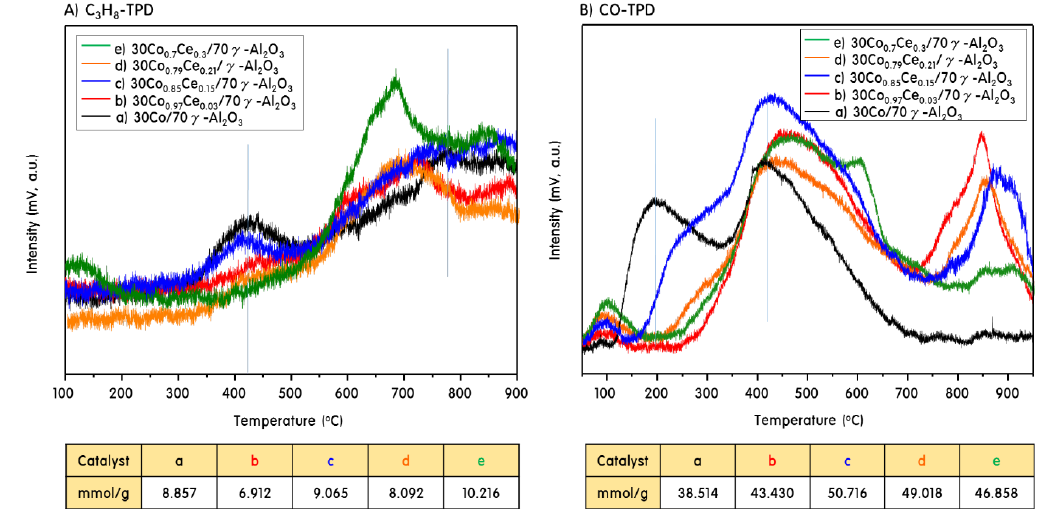
Figure 5. C 3 H 8 - and CO‐TPD curves for the fresh 30Co x Ce y /70γ-Al 2 O 3 catalysts.